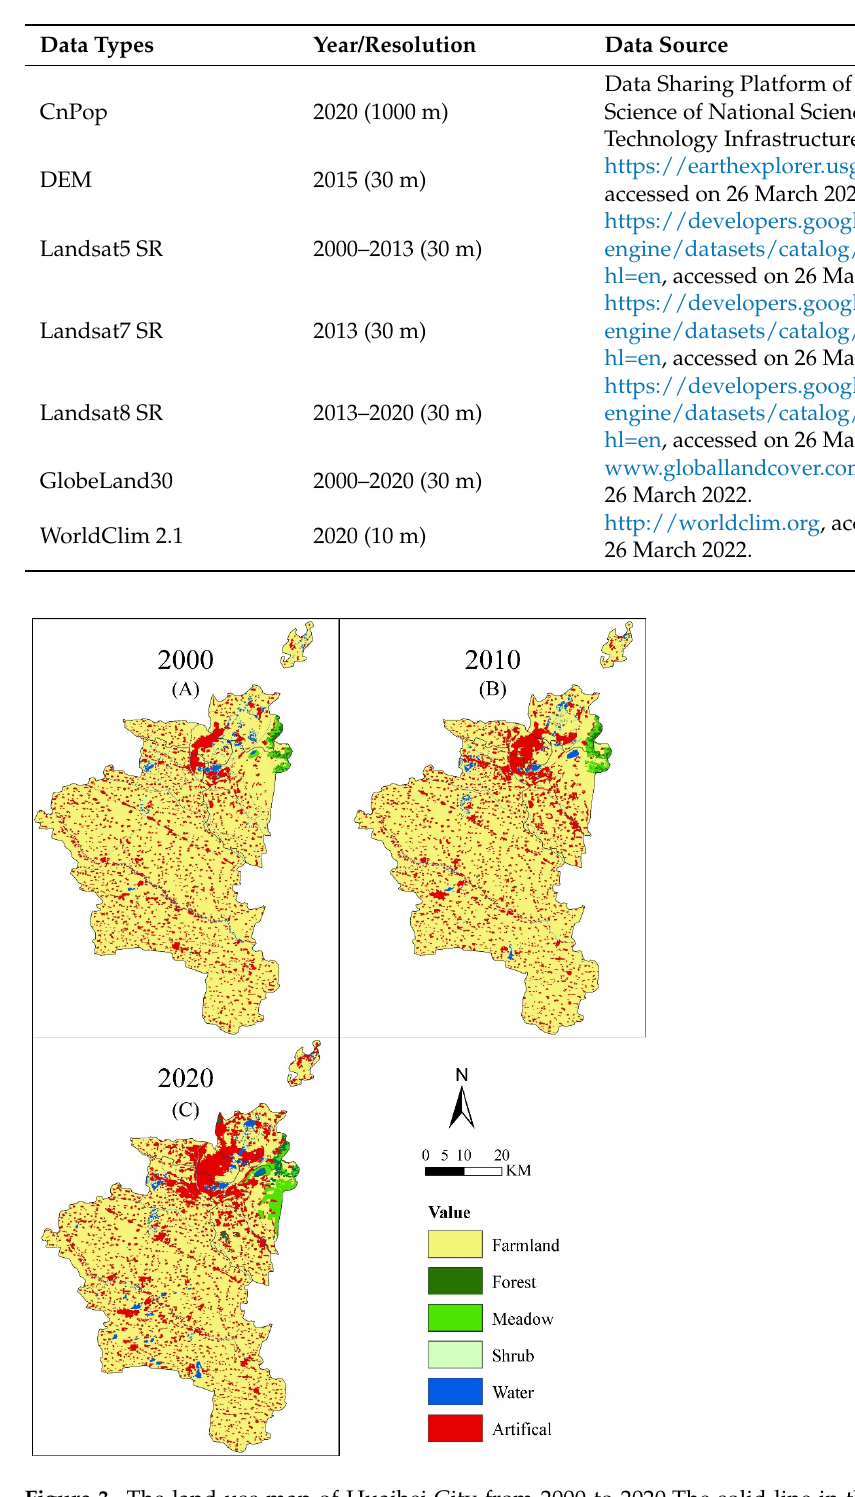
Table 1. Data Sources.